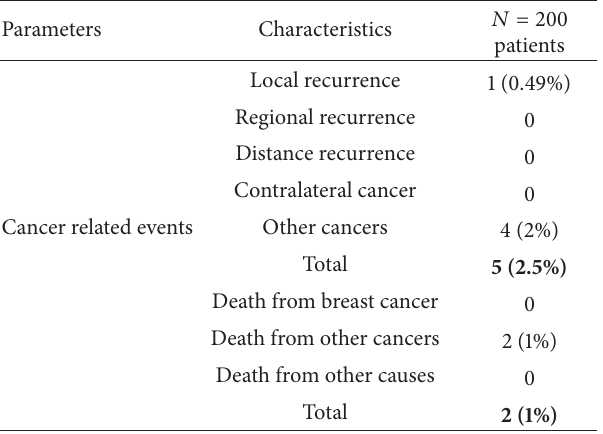
Table 1: Characteristics of our